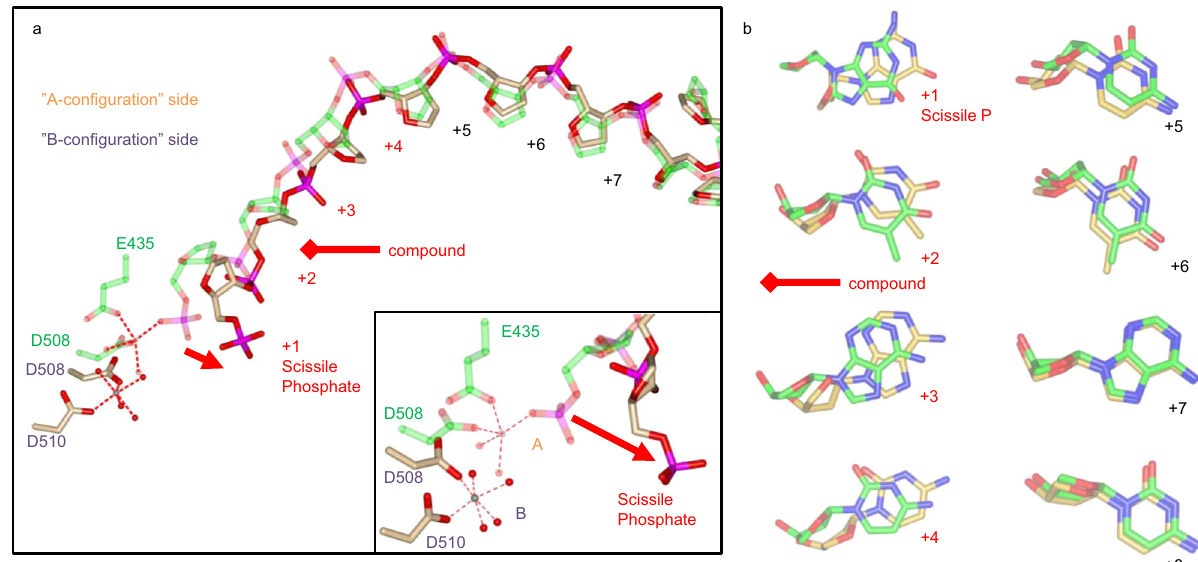
Fig. 5 Asymmetry of compound binding correlates with an asymmetry of catalytic pocket con fi guration. a Superimposition of the two 5 ′ DNA strands with the tower domain and the WHD domain as references. For clarity only, the phosphate and ribose backbone is shown. This shows the two con fi gurations (A and B) adopted by the metal (see inset). On one side, the A metal contacts the scissile phosphate. On the other side, the scissile phosphate is away from the metal, which is in the B con fi guration. The superimposition also shows the shifting of the phosphate from nucleotide + 1 (scissile phosphate) to + 4, around the compound (red arrows). b The shifting of the phosphate position correlates with a rotation of the bases around the double-helix axis observed only for two nucleotides on each side of the compound. One DNA strand is coloured in green, the complementary strand in tan, while O, N, and P are colour coded by